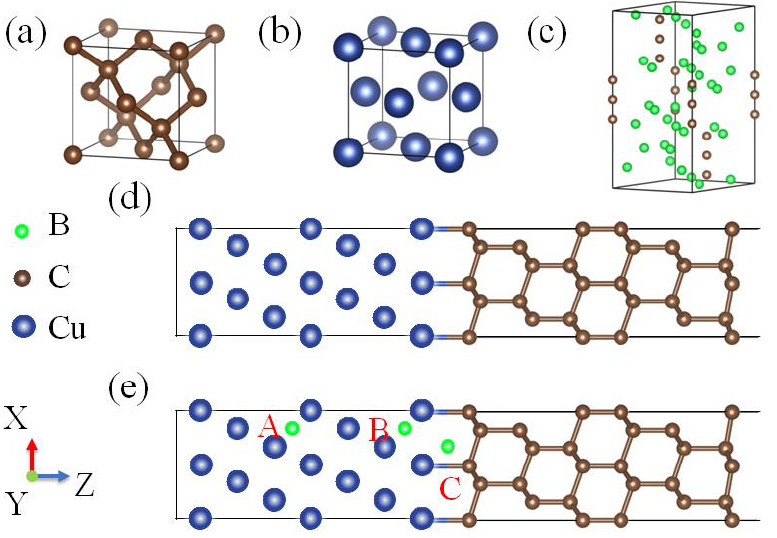
Figure 1. The structures of: ( a ) diamond-cubic lattice of diamond; ( b ) fcc lattice of copper; ( c ) B 4 C; and ( d , e ) diamond/Cu interfaces without and with boron segregation. A, B and C denote different sites for boron.